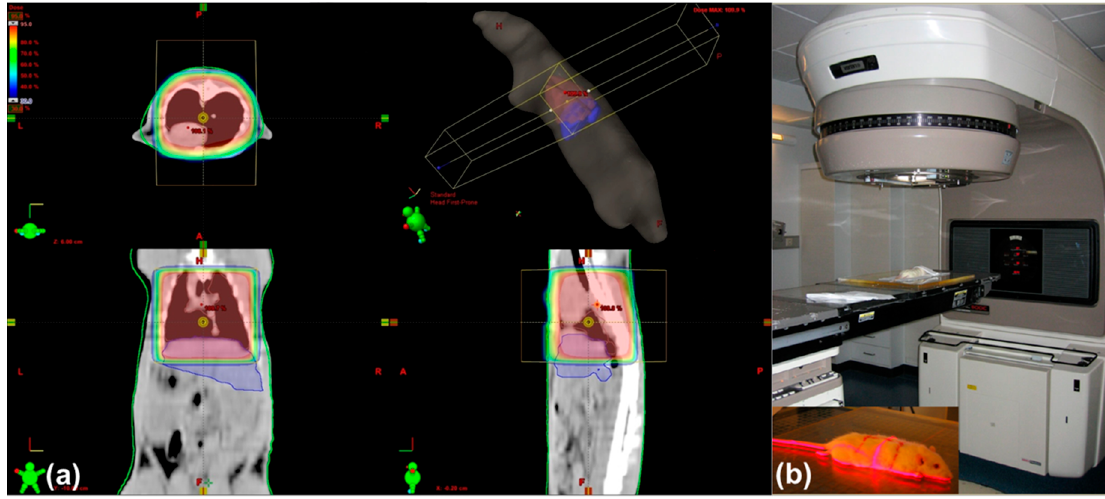
Figure 10. Planning CT-scan and dose distribution ( a ). The area for lung irradiation was marked on the fur of the rats. This area was then irradiated in a two-field technique ( b